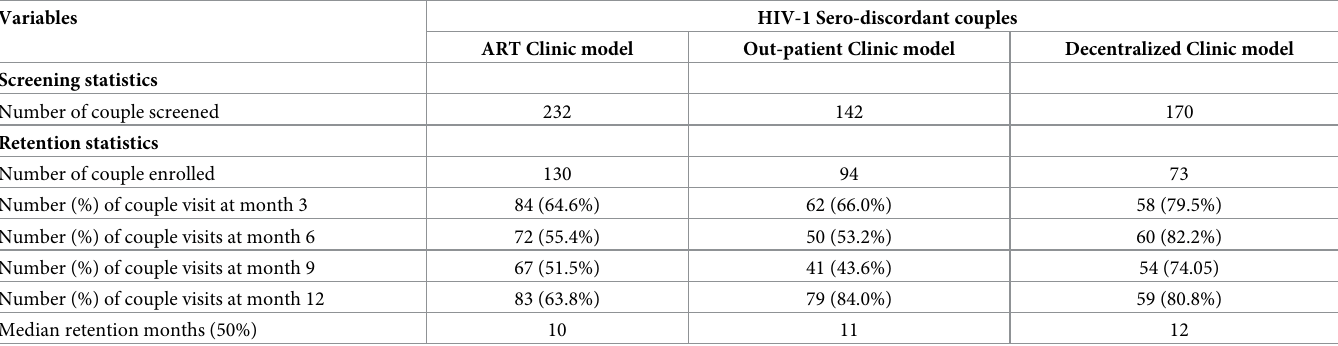
Table 2. Retention data at 3, 6, 9 and 12 months by PrEP